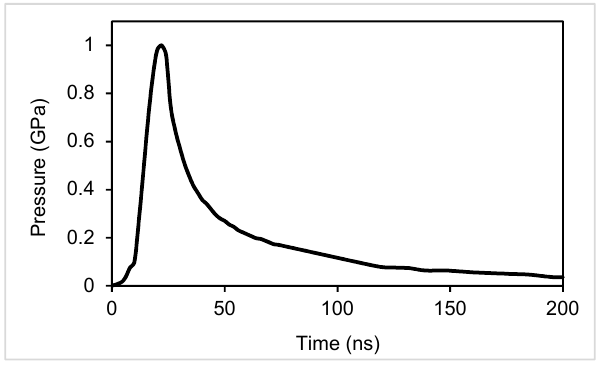
Figure 4. The applied pressure profile adapted from [9].